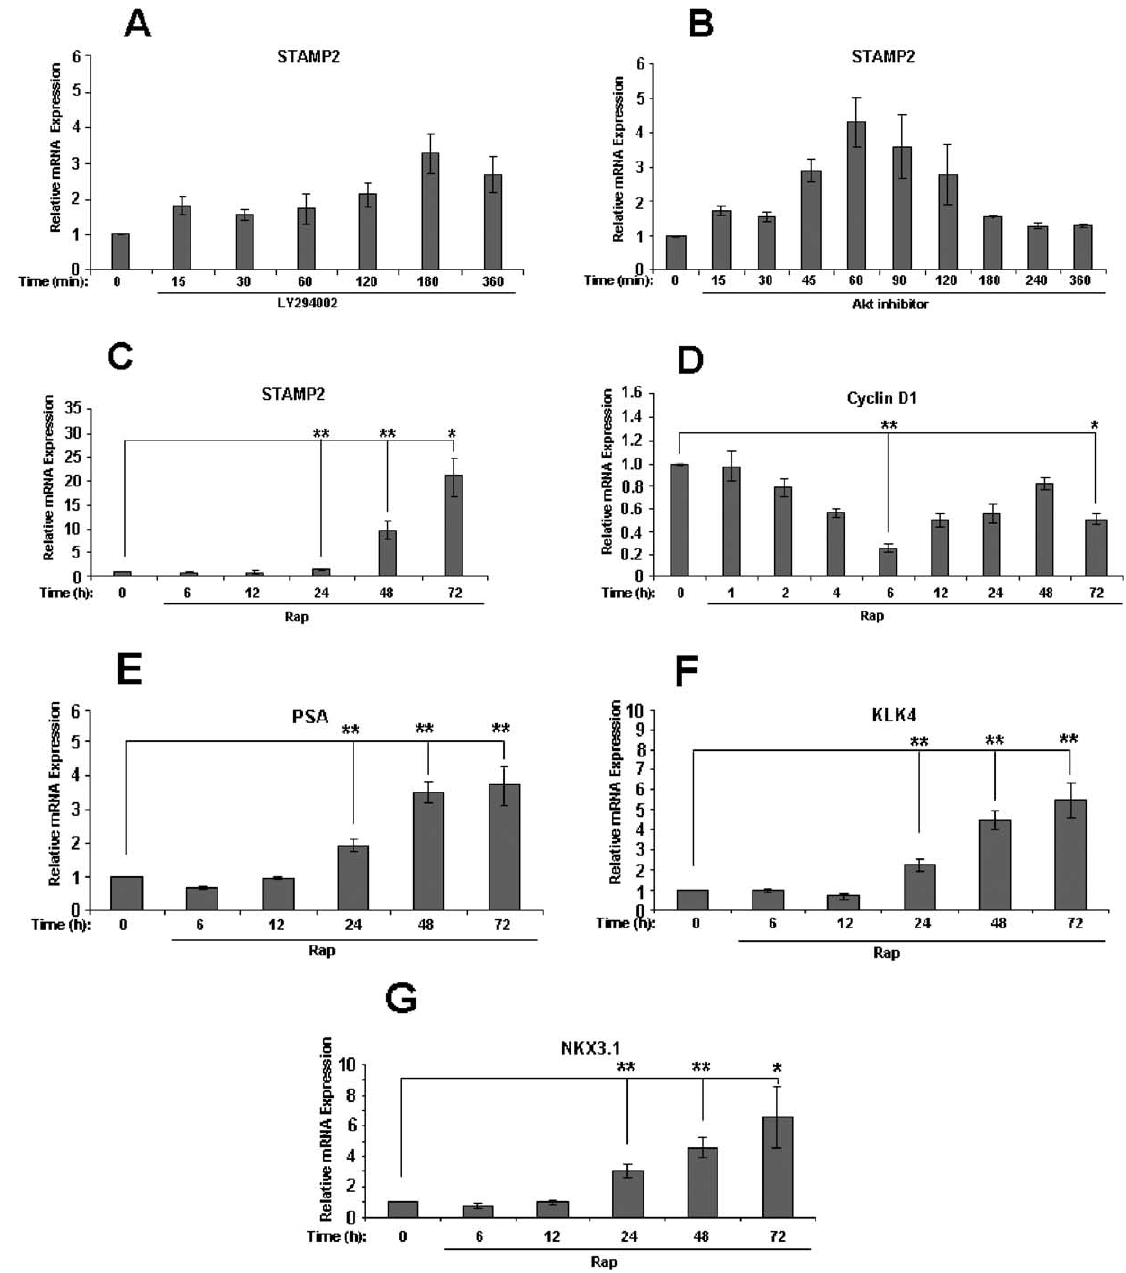
Fig. 1. The PI3K-AKT-mTOR pathway negatively regulates AR target gene expression. Quantitative RT-PCR (qPCR) was performed on cDNA made from RNA of LNCaP cells grown in 10% FCS and treated with the respective drugs as indicated; TBP was used as a housekeeping gene. (A) Cells were treated with PI3K-inhibitor LY294002 (10 µM) for different time points and STAMP2 mRNA levels were determined. (B) Cells were treated with AKT-inhibitor (10 µM) for different time points and the differences in STAMP2 mRNA levels were investigated. (C–G) Cells were treated with the mTOR-inhibitor rapamycin (100 nM) for different time points. Differences in the STAMP2 (C), cyclin D1 (D), PSA (E), KLK4 (F), and NKX3.1 (G) mRNA levels were determined. The experiments were performed three times in triplicates, error bars represent ± SEM. The expression levels are relative to non-treated cells (set to 1). The differences between the groups were evaluated using one-tailed, paired Student’s t- test compared to non-treated samples, with P < 0 . 05 being considered as significant. Significance is indicated by asterisks; one asterisk indicates P < 0 . 05, two asterisks indicate P < 0 .